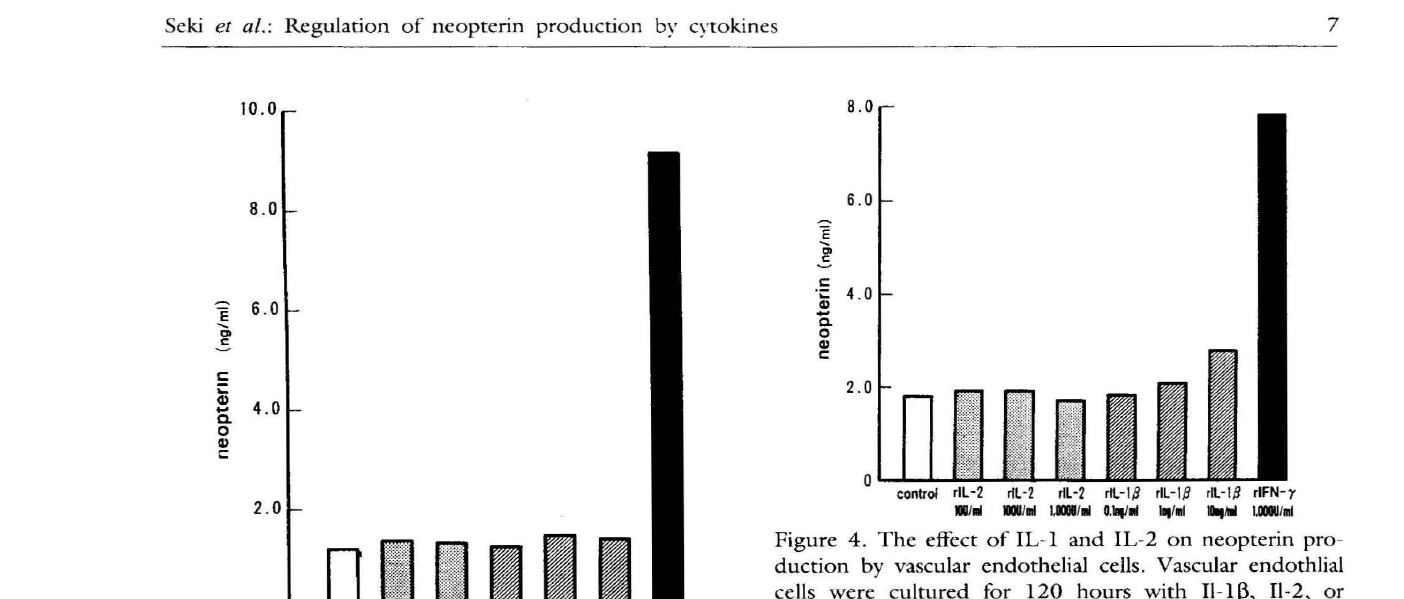
Figure 3. The effect of IL-l and and IL-2 on nepoterin production by monocytes. Monocytes were cultured for 120 hours with IL-II3, IL-2, or IFN -y. Neopterin in each supernatant was determined using RIA.